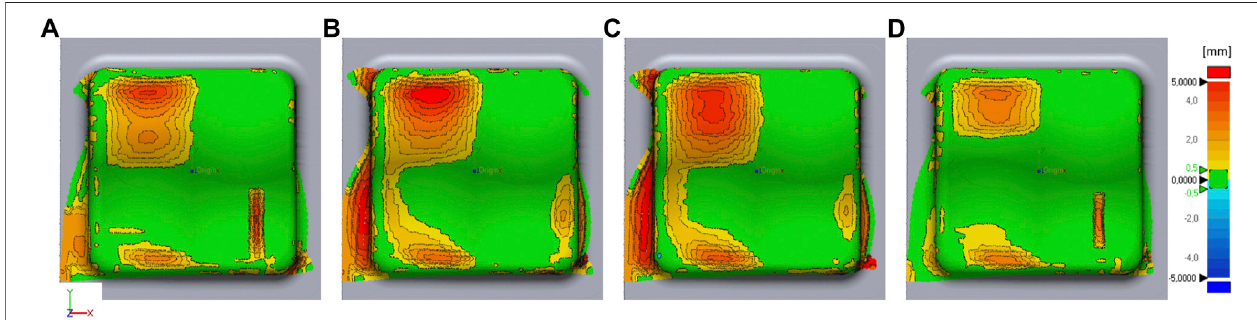
FIGURE 12 | Effects of bending calibration methods plotted against the benchmark simulation; (A) linear immediate, (B) bilinear long-term, (C) bilinear immediate responsein fi berdirectionwithalinearapproachforthetransversedirectionand (D) linearlong-terminthe fi berdirectionandbilinearstepforthetransversedirection.The distancebetweenthebenchmarksimulation(reference)andmodi fi edsimulationiscolorcoded,wheregreenareasare±0.5 mm,yellowtoredareasare > +0.5 mm,and blue areas < − 0.5 mm